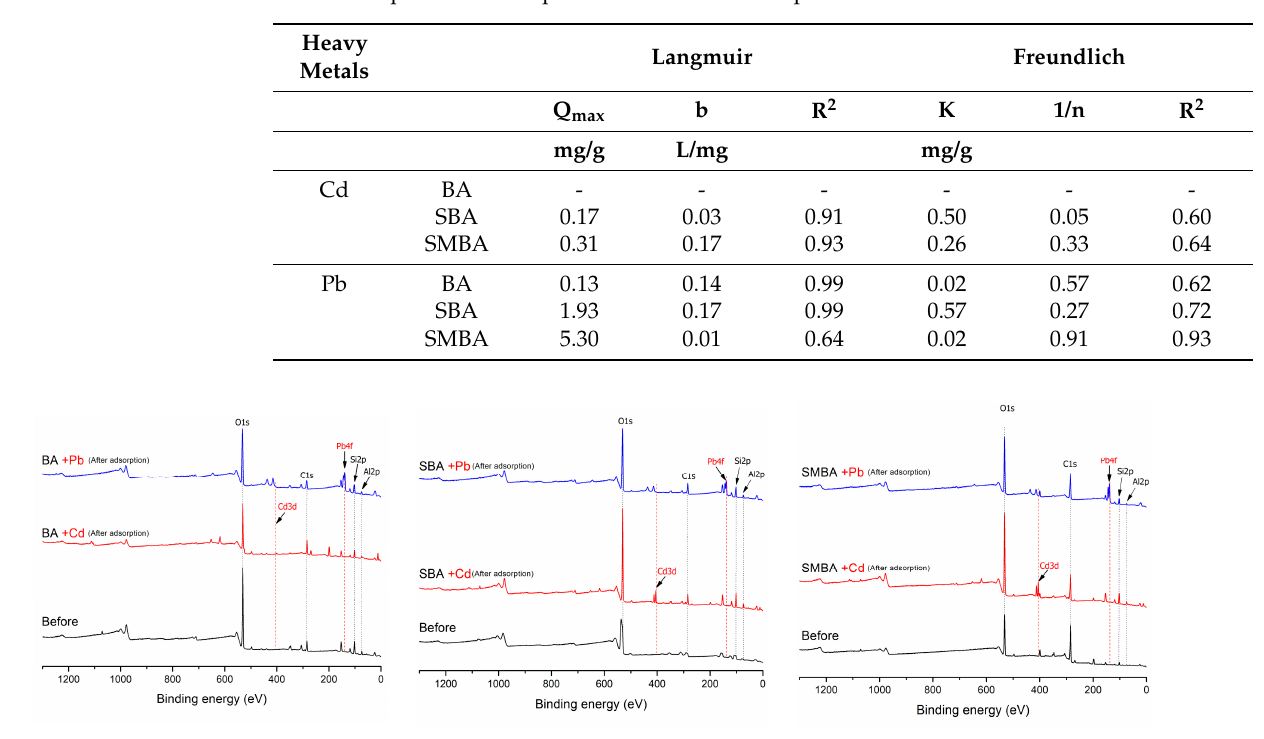
Figure 6. XPS spectra of ( a ) Pb4f for BA, ( b ) Pb4f for SBA, ( c ) Pb4f for SMBA. 4. Conclusions The modification of BA via the sintering process was evaluated for heavy metal sorp- tion. The sintering process altered the morphology of the original BA, increasing the po- rosity. During the sorption process, initial rapid sorption occurred in the SBA, and equi- librium was attained after 6 h. The highest sorption efficiency with the SBA was achieved at 98.16% for Cd and 98.41% for Pb. The sorption kinetics of Cd and Pb with modified sorbents showed that pseudo-second-order kinetics strongly represented the sorption process, indicating that chemical complexation was the dominant sorption process. This result is also supported by XPS analysis, which revealed that chemical precipitation oc- curred for Cd, including Cd(OH) 2 and CdCO 3 . In the case of Pb, the complexation with oxygen (PbO) or sulfur (PbS) occurred on the surface of the SBA. However, no beneficial effect was observed when the microorganisms were mixed with the SBA.